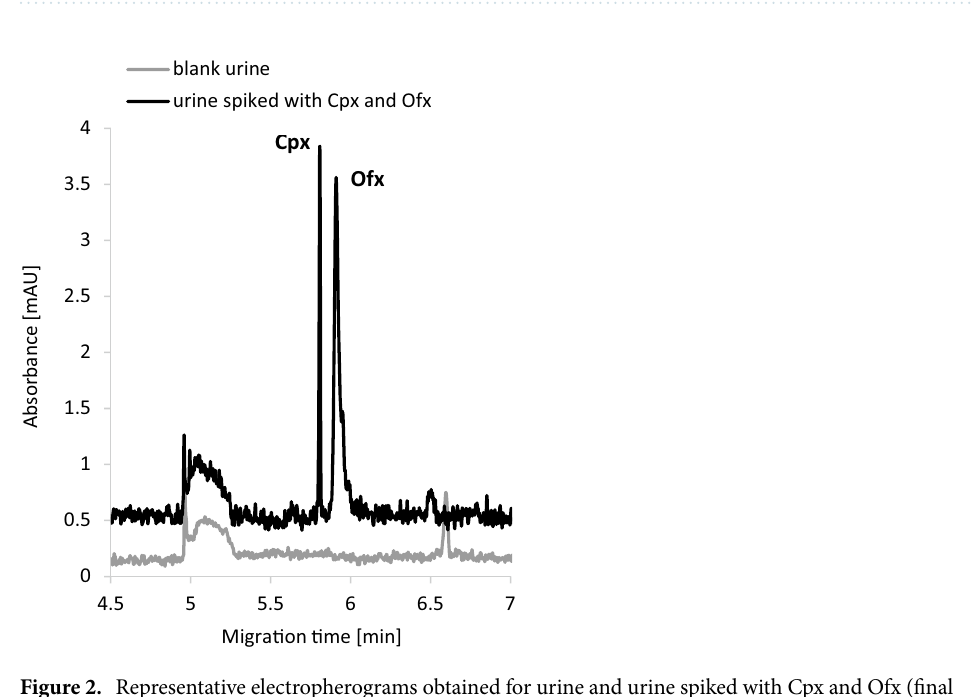
Table 4. Determination of Cpx and Ofx in human urine—results. *n = 3.